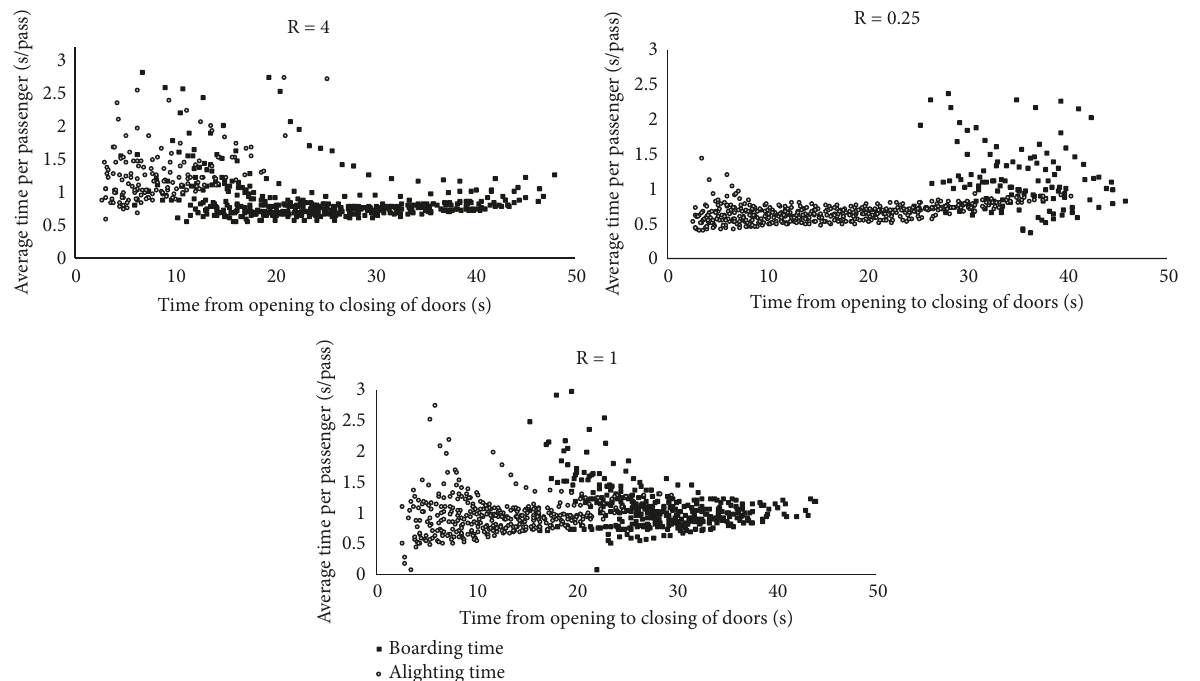
Figure 5: Average boarding time per passenger j ( 𝑡 𝑏𝑗 ) and average alighting time per passenger i (𝑡 𝑎𝑖 ) at PAMELA when crowded situations are reached at the